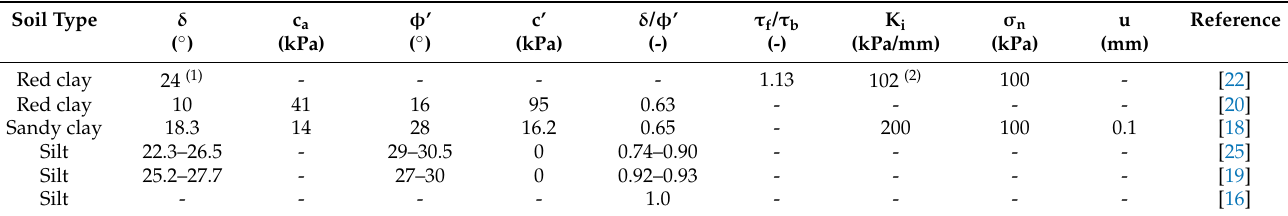
Table 1. Smooth concrete interface testing dataset.